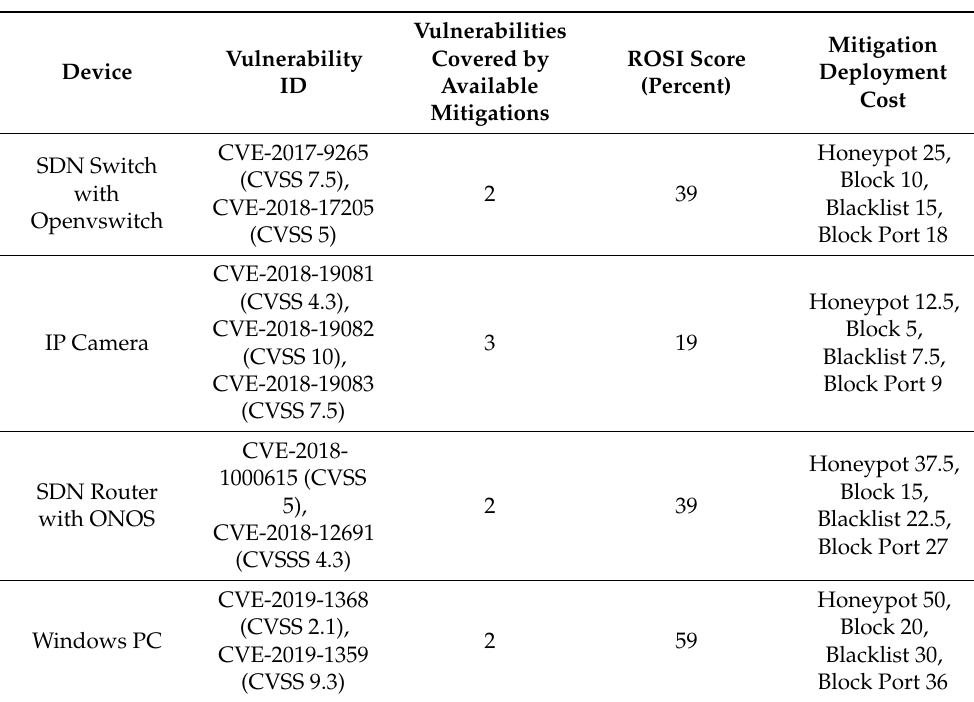
Table 4. Mitigation engine